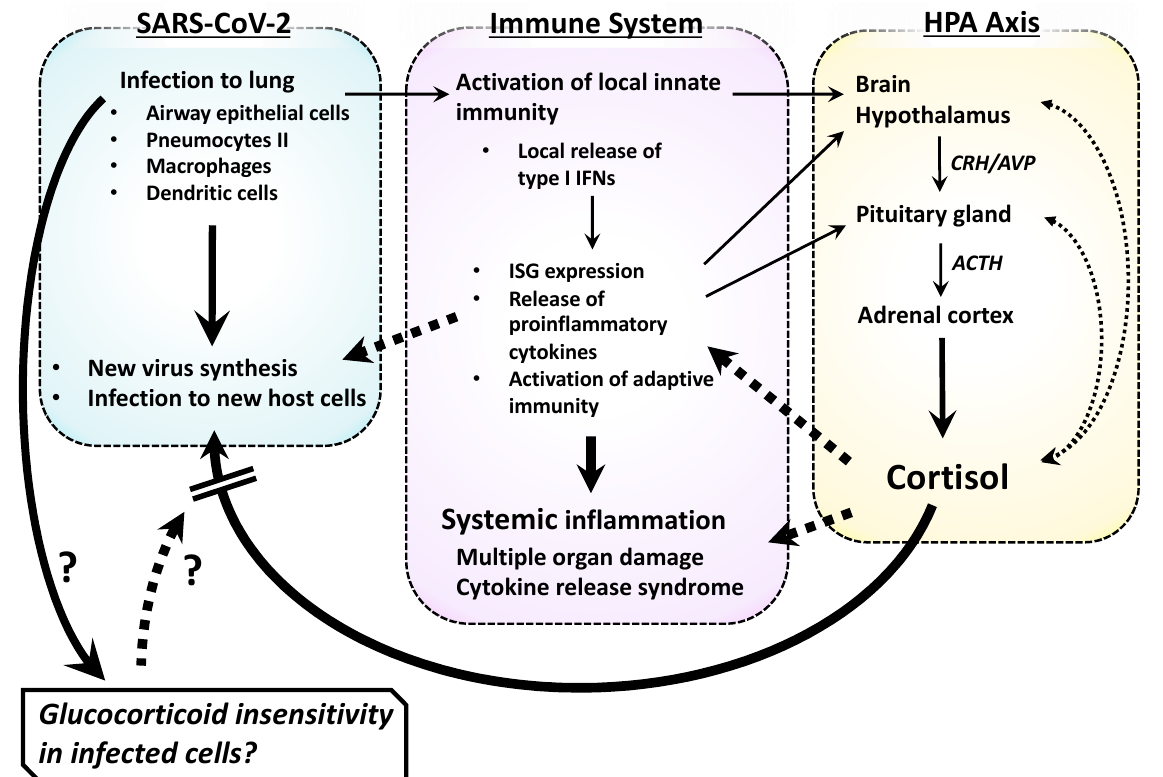
Figure 3. Interaction network between the SARS-CoV-2 infection at local tissues, the host immune system and the HPA axis. SARS-CoV-2 initially infects the lung (e.g., respiratory epithelial cells, pneumocyte II and residential macrophages and dendritic cells) and synthesize its new viral particles inside these cells. Infection of the virus to host tissues activates local innate immune system and production of type I IFNs, which in turn stimulate expression of anti-viral ISGs and release of proinflammatory cytokines, and activate adaptive immunity. Such host immune activation leads to induction of the systemic inflammation, which sometimes progresses into multiple organ damage/cytokine release syndrome. Local inflammation as well as circulating proinflammatory cytokines activate the HPA axis, and stimulate secretion of its end-effector cortisol into systemic circulation. The liberated cortisol strongly suppresses tissue inflammation but also inhibits host anti-viral innate immunity. Coincidentially, the virus appears to block the latter effect of cortisol in infected cells by developing glucocorticoid insensitivity during the process of shifting host cell activities toward its own replication. Solid lines indicate positive effects, while dashed lines are for negative effects. ACTH: adrenocorticotropic hormone, CRH: corticotropin releasing hormone, IFN: interferon, ISG: IFN-stimulated genes.